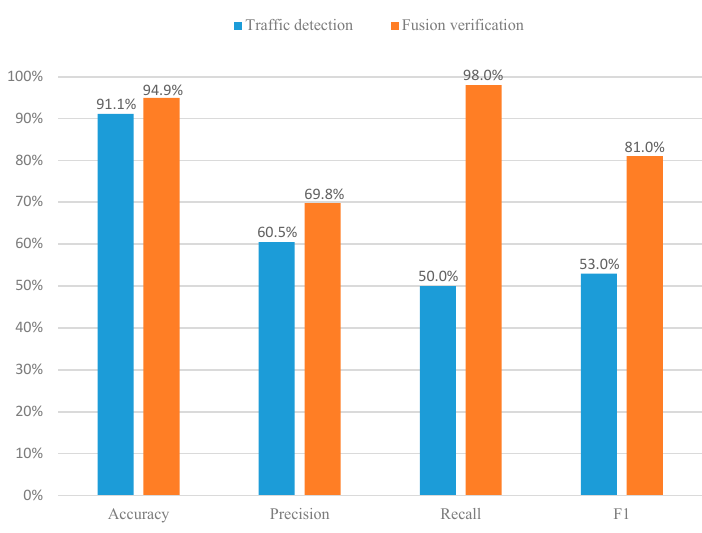
Figure 3. Average performance comparison.